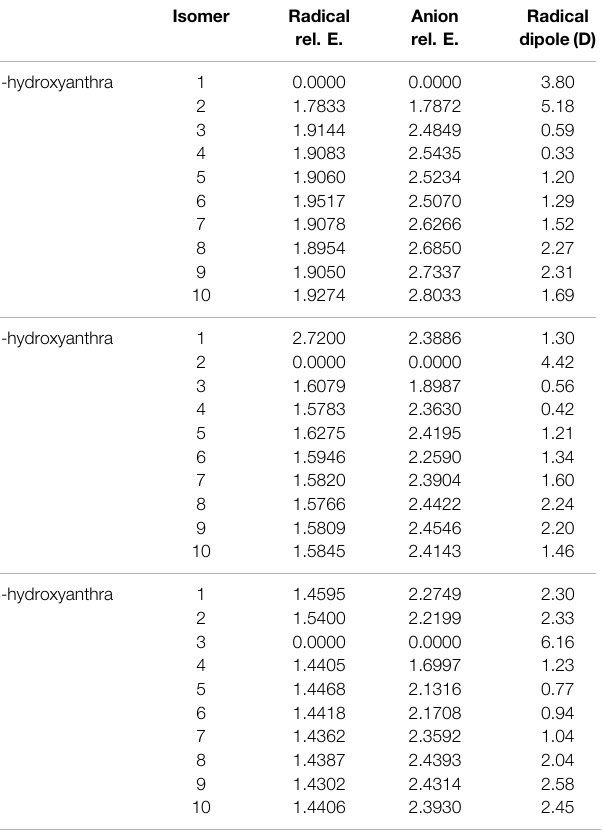
TABLE 8 | The singly deprotonated hydroxyanthracene anion derivatives eBEs TABLE 7 | The relative energies and neutral radical dipole moments of and transition energies. hydroxyanthracene derivatives. Isomer Excited states eBE Isomer Radical Anion Radical rel. E. rel. E. dipole(D) 2 1 A